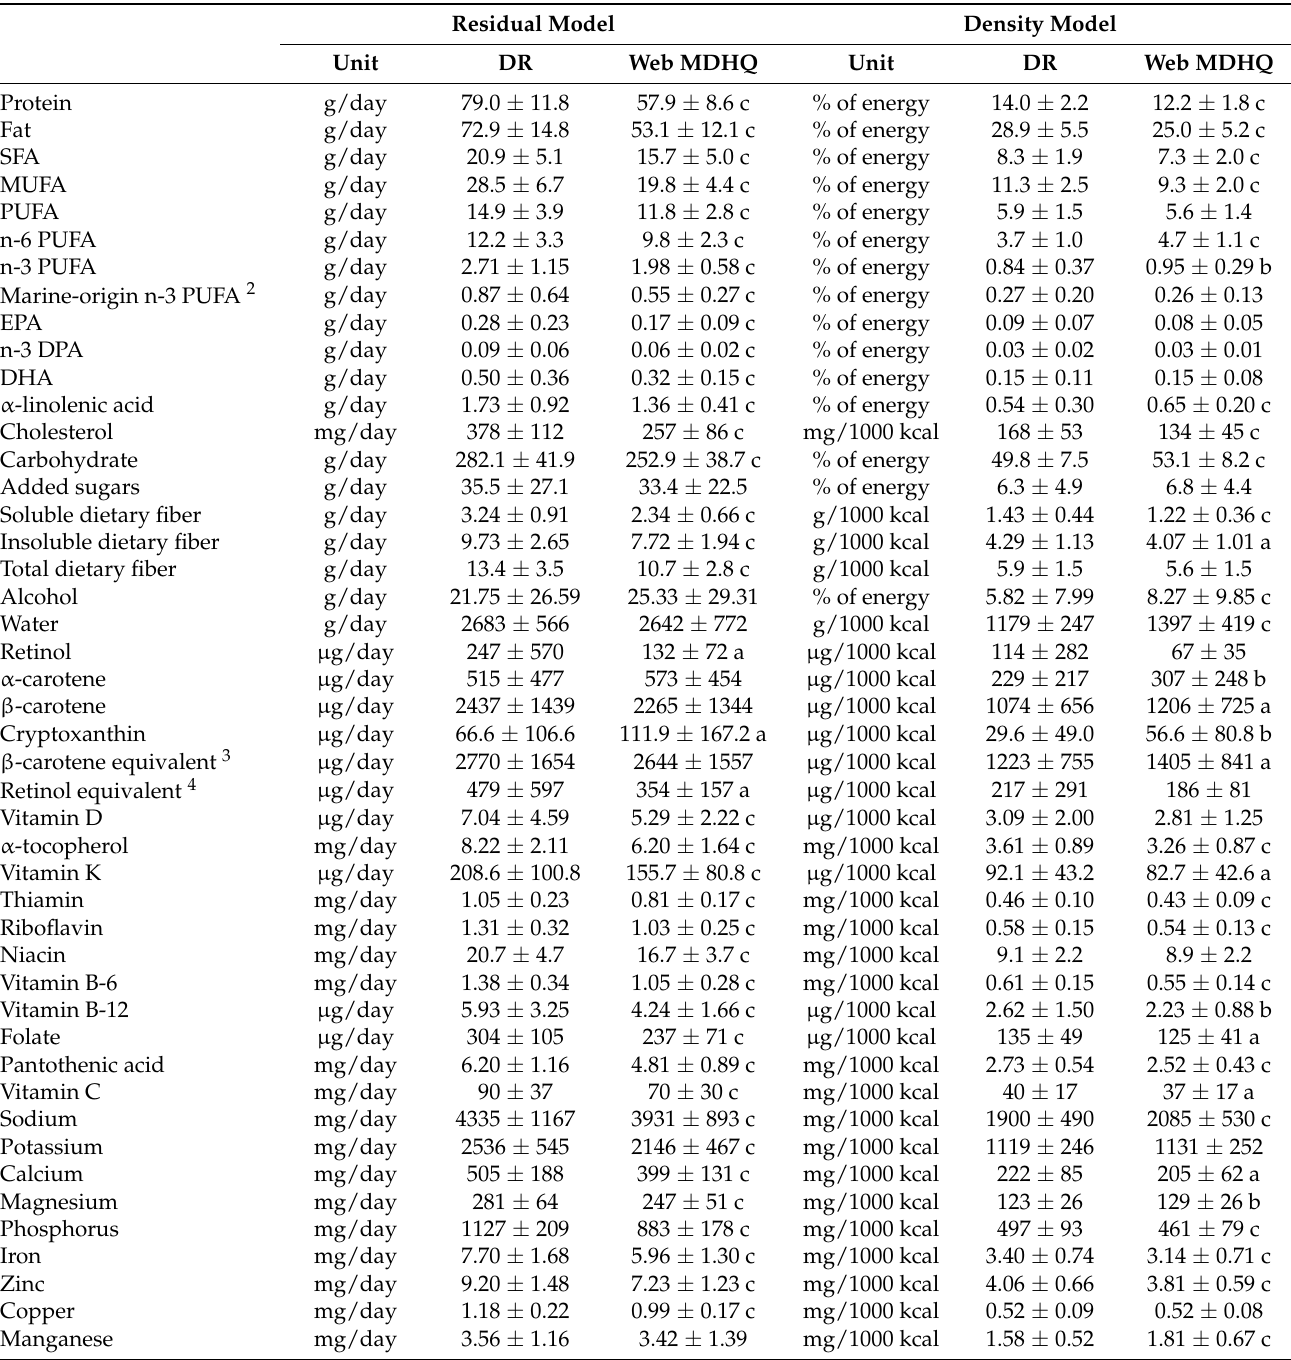
Table 3. Mean estimates of energy-adjusted intakes of nutrients obtained from the 4-day weighed dietary record (DR) and those obtained from the web version of the Meal-based Diet History Ques- tionnaire (MDHQ) in 111 Japanese men 1